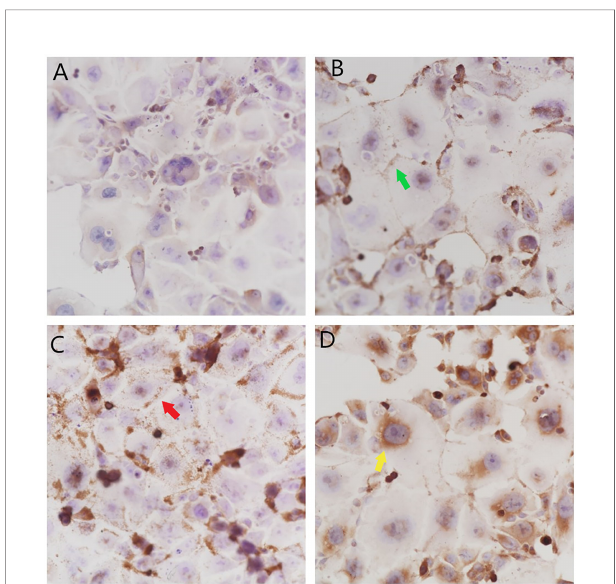
FIGURE 1 | Localization and expression of PD-L1, PD-1, and Foxp3 in colon HCT-116 cells. (A) The negative control group (× 400) showed no obvious brown granule deposition. (B) The PD-L1 group (× 400) showed brown granule deposition on the cell membrane and a small amount of brown granule deposition in the cytoplasm. (C) The PD-1 group (× 400) showed a large amount of brown granule deposition on the cell membrane and a small amount of brown granule deposition in the cytoplasm. (D) The Foxp3 group (× 400) showed a large amount of brown granule deposition in the nucleolus and on the nuclear membrane